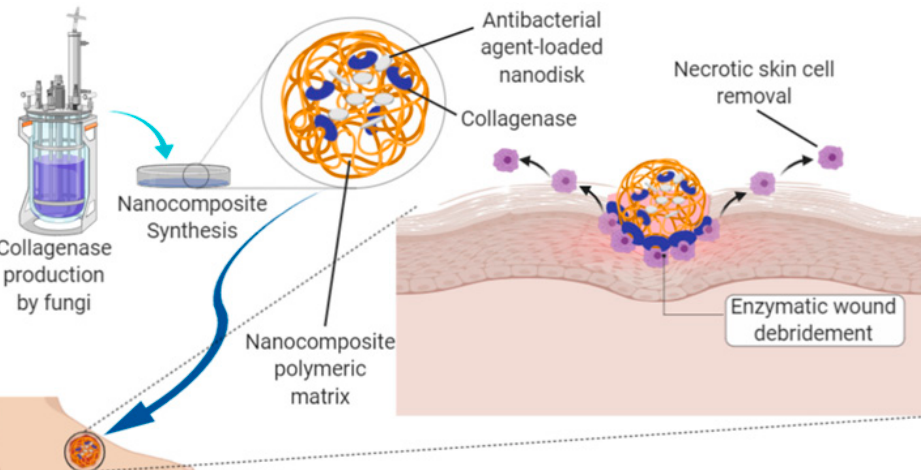
Figure 4. Schematic representation of the formulation of an optimized nanocomposite material by encapsulating enzymes, such as collagenase, gelatinase, or trypsin, within a polymeric matrix for treating the main setbacks in the wound healing process of diabetic foot